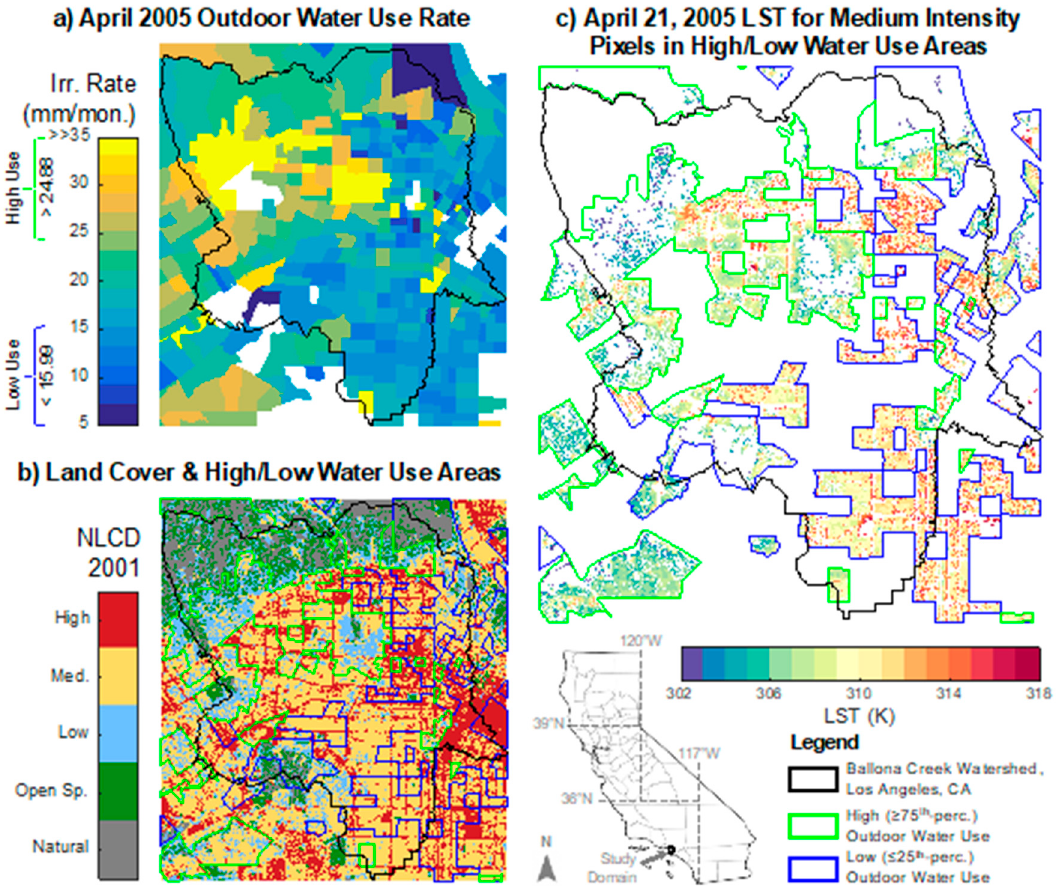
Figure 1. Study domain and land surface temperature classification methodology: ( a ) Estimated outdoor water use data for a typical month (April 2005), ( b ) high and low water use areas overlying the NLCD 2001 land cover (Developed, High Intensity; Developed; Medium Intensity; Developed; Low Intensity; Developed; Open Space; “Natural” refers to all other land cover), ( c ) medium intensity developed LST pixels from the 21 April 2005 Landsat overpass within high and low water use areas.